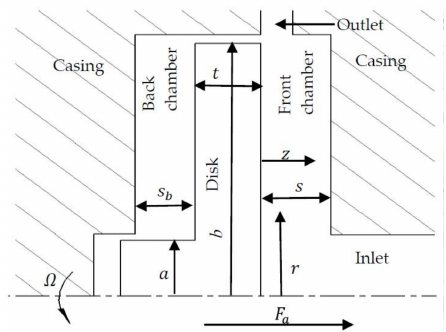
Figure 1. Geometry of a rotor-stator cavity. a : hub radius; b : outer radius of the disk; F a : axial thrust; r : radial coordinate; s : axial gap of the front chamber; s b : axial gap of the back chamber; t : thickness of the disk; z : axial coordinate; Ω : angular velocity of the